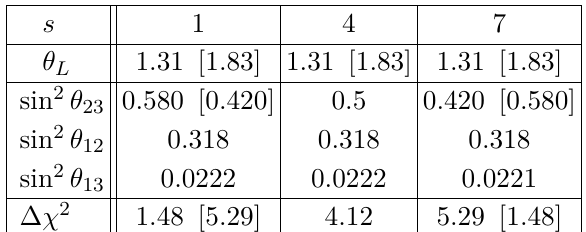
Table 3 . Case 3 b.1) Results for a small value of the index n , n = 8 , together with m = 4 . Note that not for all admitted values of the parameter s a viable fit to the experimental data on lepton mixing angles [41] can be achieved. The goodness of the fit can be read off from the value of ∆ χ 2 for light neutrino masses with NO. The presence of a second best fit value for θ square